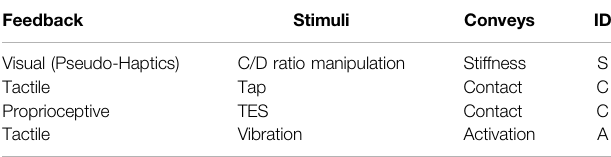
TABLE 1 | Multisensory feedback and the corresponding sensations conveyed and evaluated in experiment 2